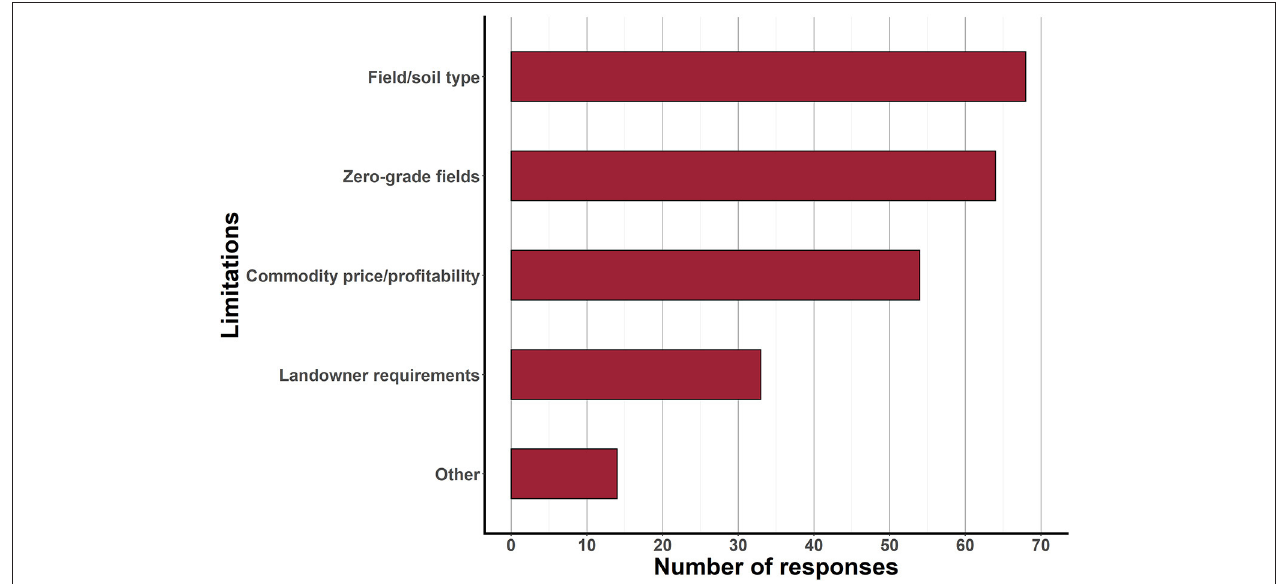
FIGURE 4 | Reported limitations for crop rotation from rice to other cropping systems ( n = 118, 233 total